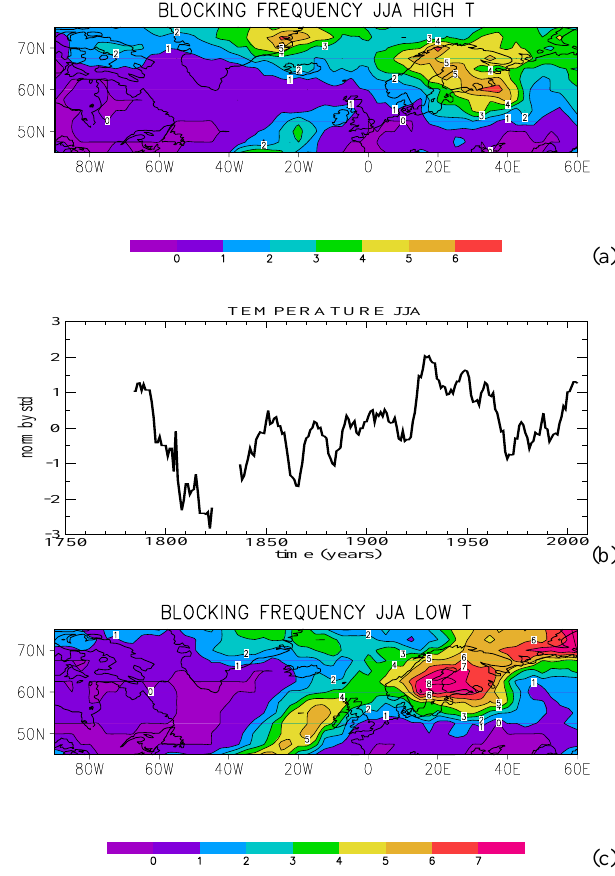
Fig. 14. (a) Blocking frequency composite for (a) high and (c) low southwestern Greenland temperatures during summer. (b) Filtered (7-year running mean) summer temperature time series for 1784– 2005